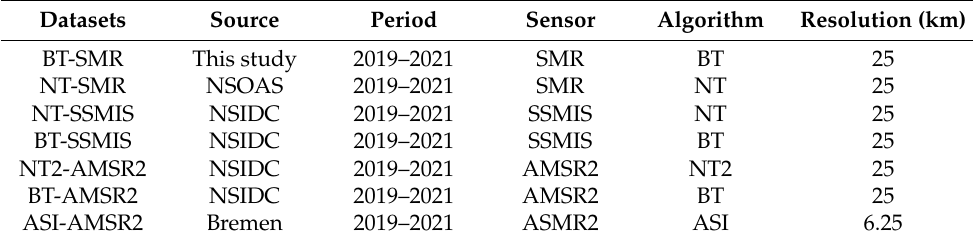
Table 3. Summary of the SIC datasets applied in this